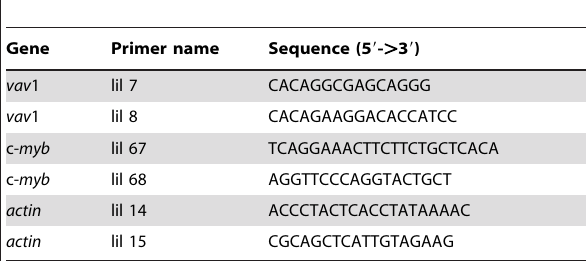
Table 4. Primers that were used for gene expression